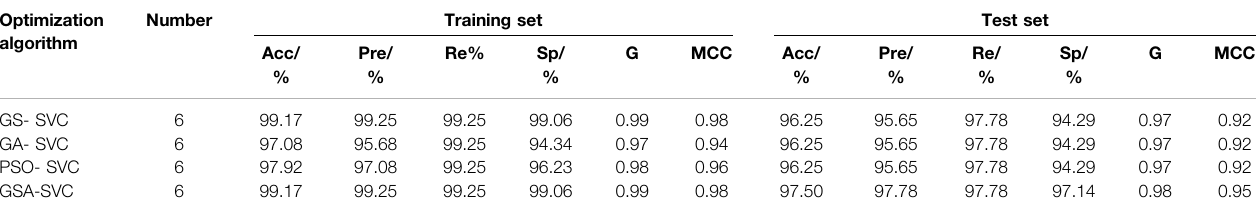
TABLE 5 | Comparison results of different intelligent optimization algorithms. Optimization algorithm